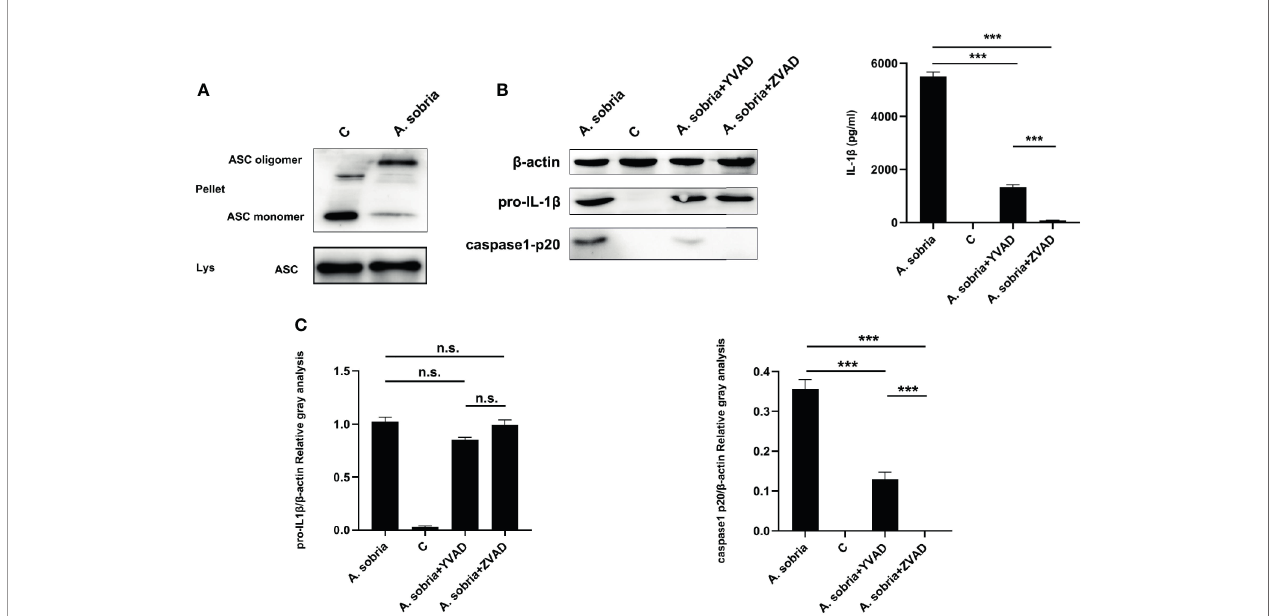
FIGURE 2 | A sobria – induced IL-1 b secretion was regulated by ASC-dependent in fl ammasome activation. PM j s (4.5 × 10 6 cells/well in six-well plate) were pretreated with either Ac-YVAD-CHO (100 m M) or zVAD-fmk (10 m M) for 1 h, infected with A sobria (MOI= 10) for 90 min, and then A sobria was discarded. After washing three times with sterile PBS, PM j s were treated with gentamicin sulfate (100 m g/ml) containing RPMI 1640 maintenance medium for 2 h to kill residual A sobria and then replaced with gentamicin sulfate (20 m g/ml) containing RPMI 1640 maintenance medium for 12 h The activated caspase-1 p20 was detected in the supernatants using western blotting, and mature IL-1 b p17 was detected in the supernatants using ELISA. No inhibitor treatment group was used as positive control group, and no A sobria inoculation group was used as negative control (C) group. (A) The ASC oligomerization levels were evaluated in the A sobria inoculation group and C group. Pellet represented cross-linked cell pellet, and Lys represented lysed cells. (B) The protein expression of caspase-1 p20, pro-IL-1 b , and mature IL-1 b was detected in the inhibitor pretreatment groups, A sobria inoculation group, and C group. (C) The relative gray values of caspase-1 p20 and pro-IL-1 b were normalized to b -actin through Image. Data were presented as mean ± Standard Deviation from three independent assays with three technical repeats. Signi fi cant difference was analyzed using SPSS software, and graph was generated using GraphPad Prism 8 software. *** represents p < 0.001, and n.s. represents p >